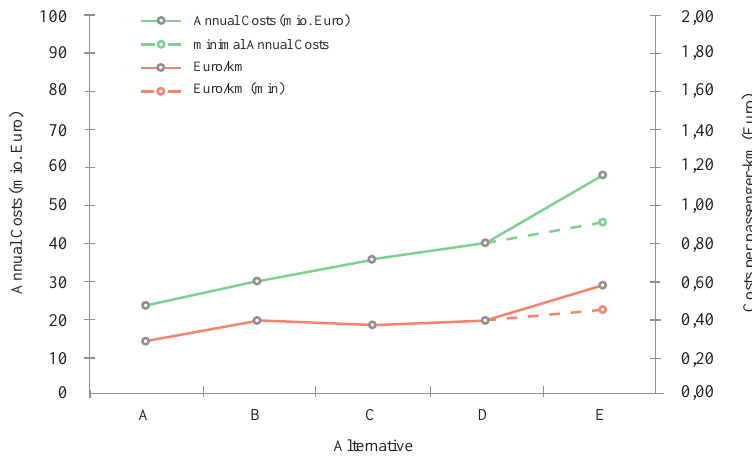
Fig. 3. Estimated annual costs and cost per passenger-km